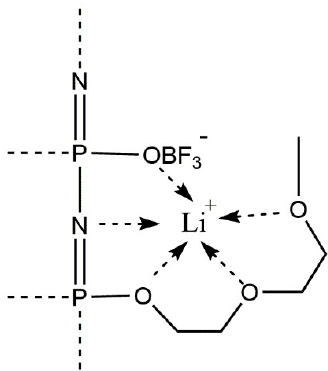
Figure 6. Illustration of coordination sites of the lithium cations by ethylene oxide sidechains, the anionic substituents and the basic nitrogen atoms in the backbone.